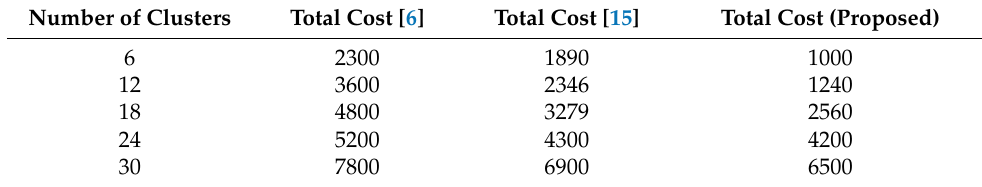
Table 6. Cost of